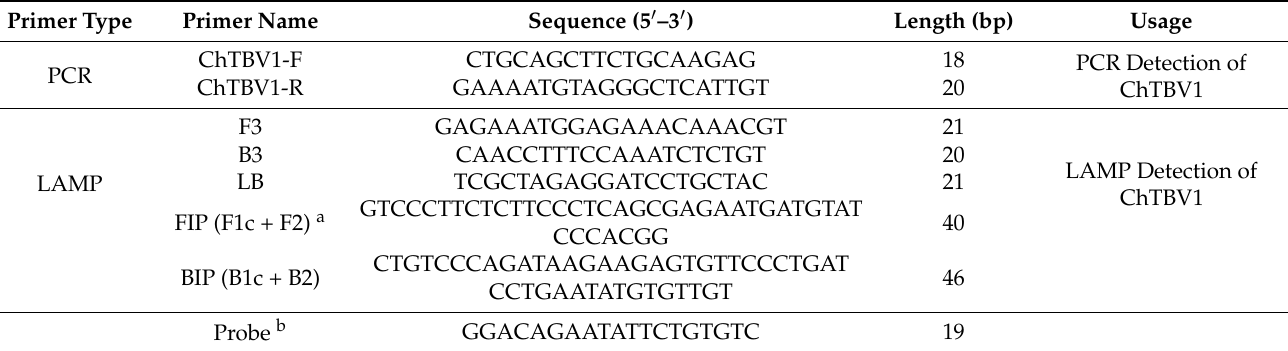
Table 1. List of primers used for detection of ChTBV1 by